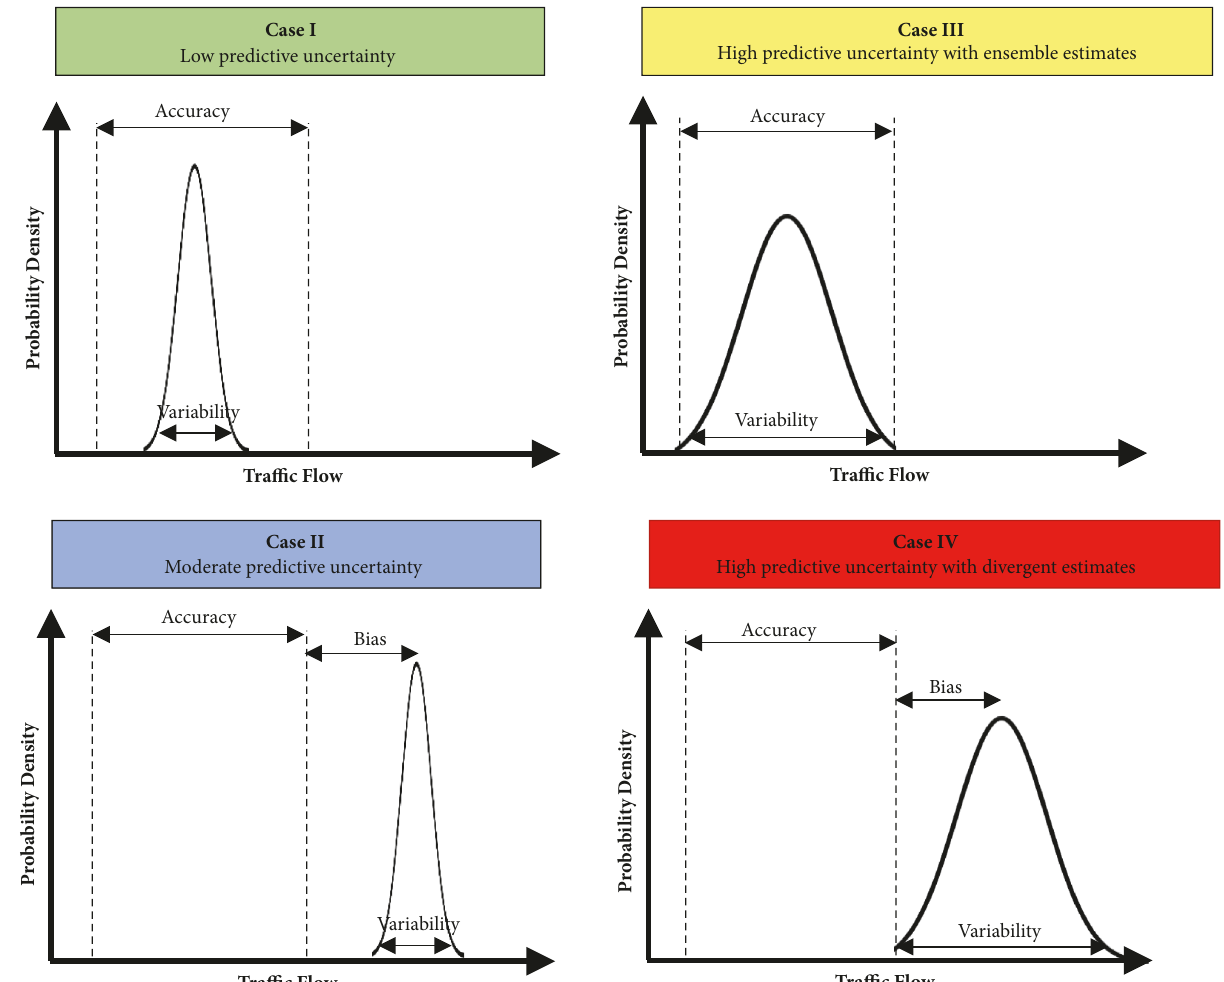
Figure 3: The probability density curves of the predicted traffic flow for the four